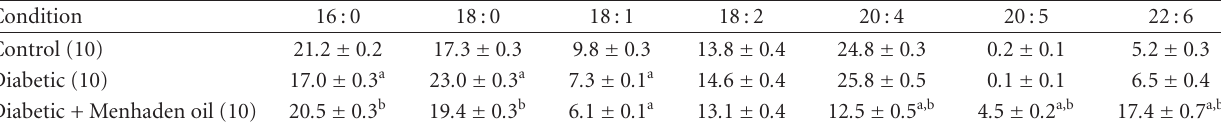
Table 5: E ff ect of Partial Menhaden Oil Substitution on Fatty Acid % Composition of Liver Measured by Gas Chromatography.